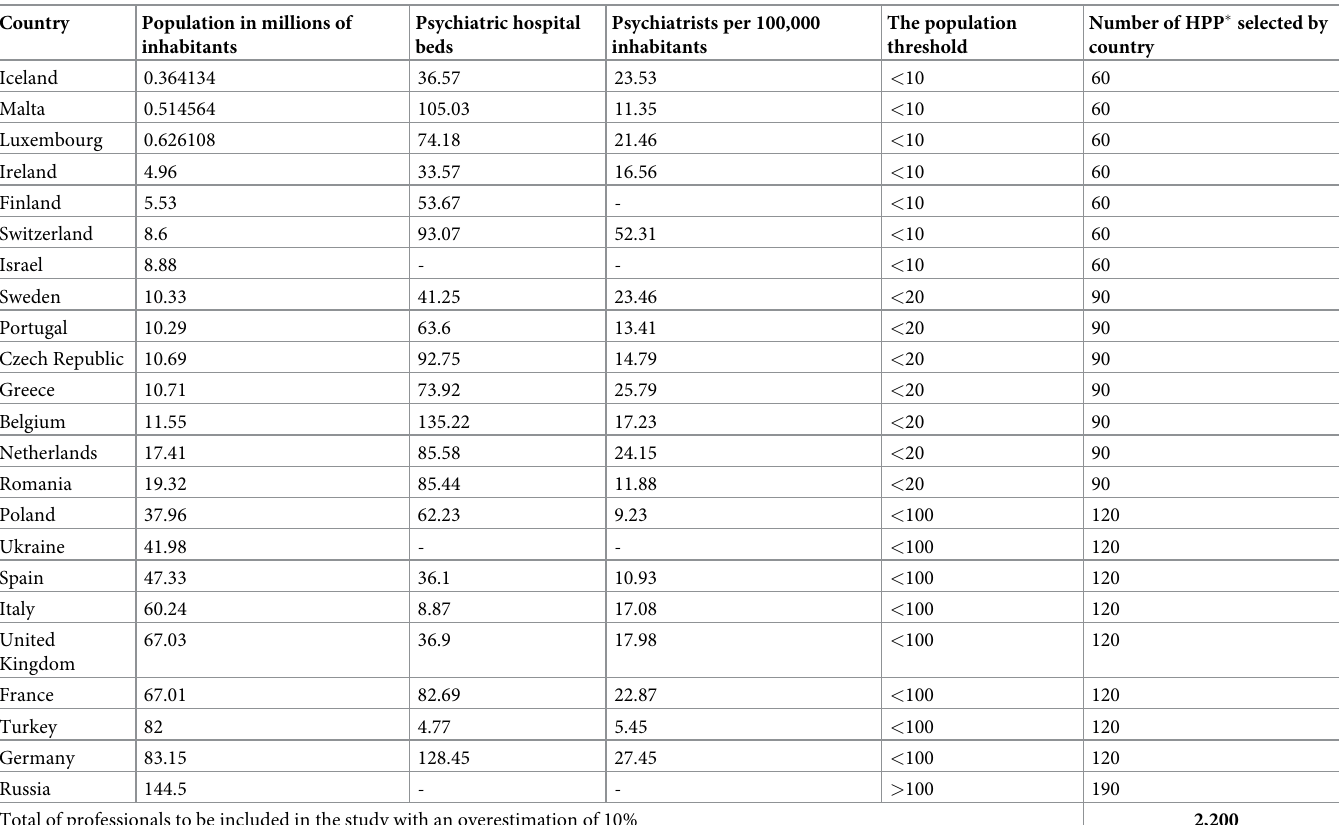
Table 1. Selection criteria for the questionnaires among